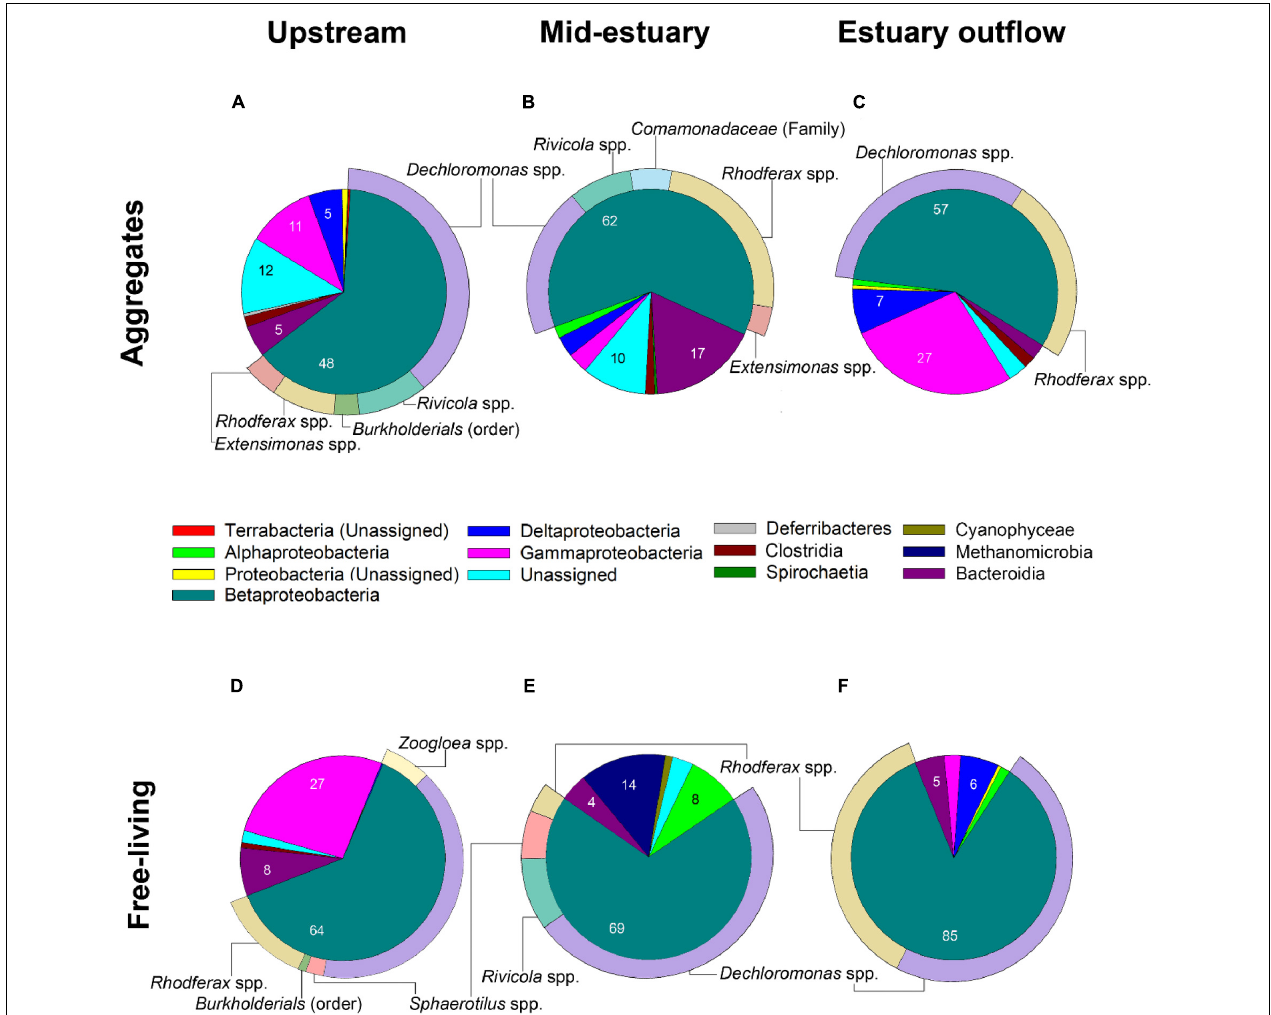
FIGURE 6 | Wintertime diazotrophic community composition at the Qishon River derived from nif H analyses associated with aggregates (A–C) and as free-living bacteria (D–F) . Numbers represent relative abundance (%, mean = 5,300 OTUs) of class level OTUs in the sample. Sub-pie slices represent the genus of the most abundant (and assigned) class in a sample. The remaining classes are shown in Supplementary Table 2